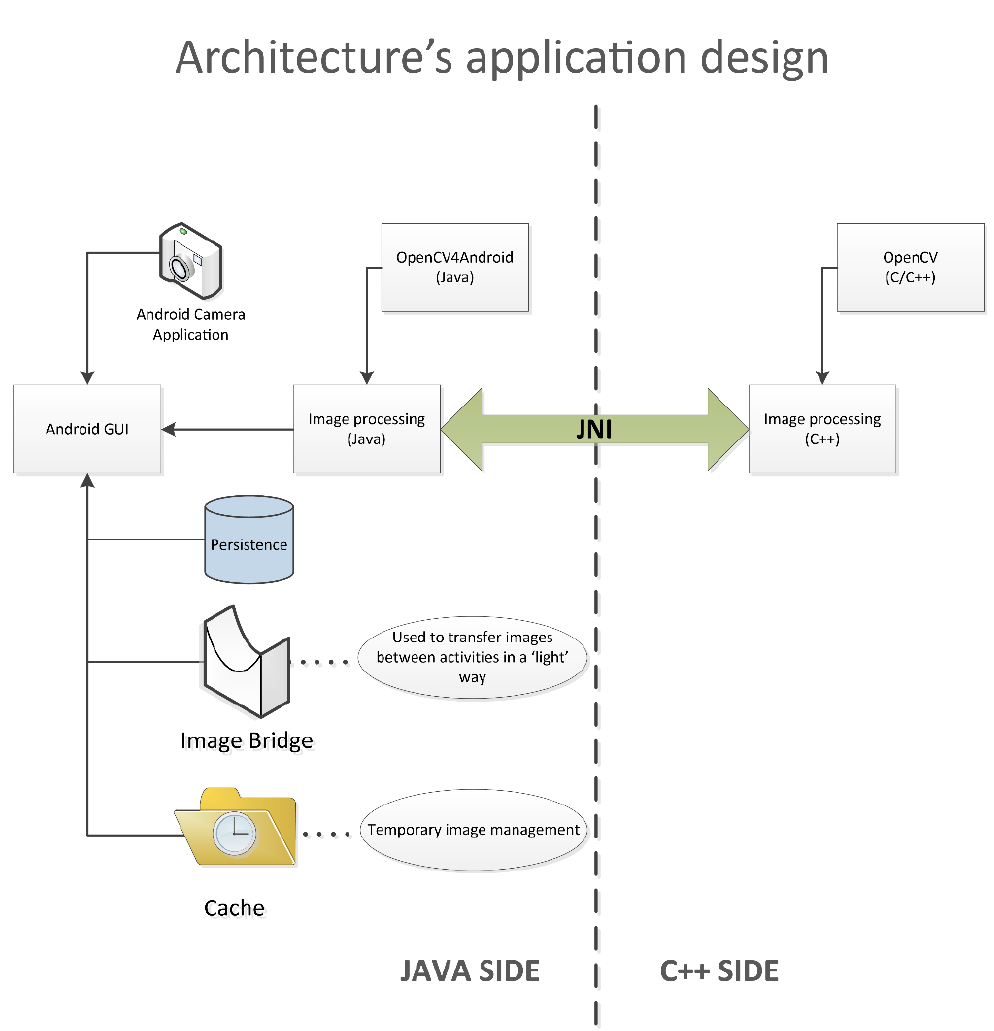
Figure 2. Architecture design of the vitisFlower ® Android